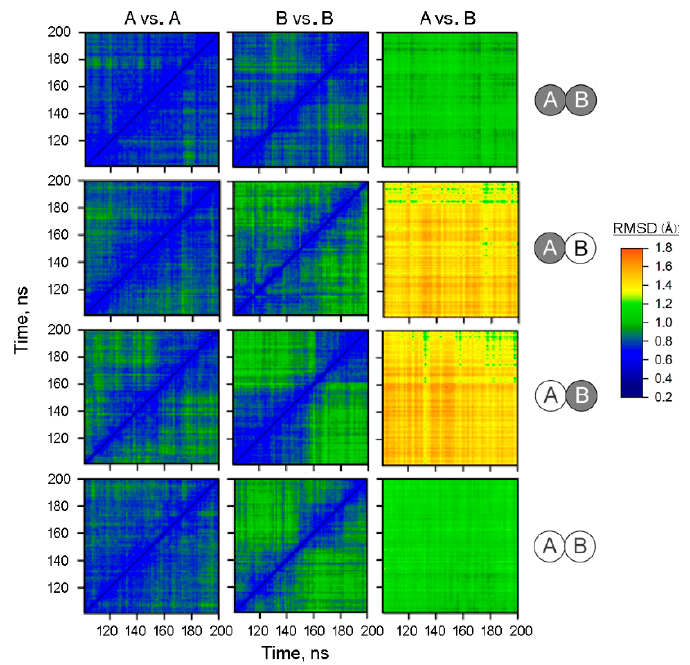
Figure 1. 2D-RMSD analysis of the MD trajectories of the IDP complexes of Vr-mPPase of different stoichiometry. Structure snapshots were taken each 1 ns between 100 and 200 ns of the simulation. The RMSD values shown refer only to α -helix backbone atoms. The IDP content of subunits A and B in the dimer is indicated on the right; IDP-free and IDP-bound subunits are shown as open and closed circles, respectively. The top labels indicate the subunits compared. Points are colored according to the RMSD value, as shown on the color scale.